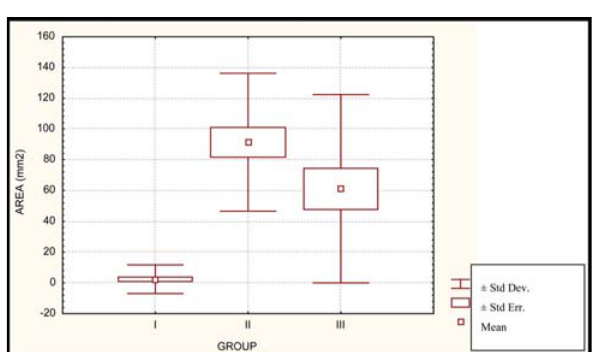
FIGURE 11 - Animals distribution in relation to the adhesion area according to the